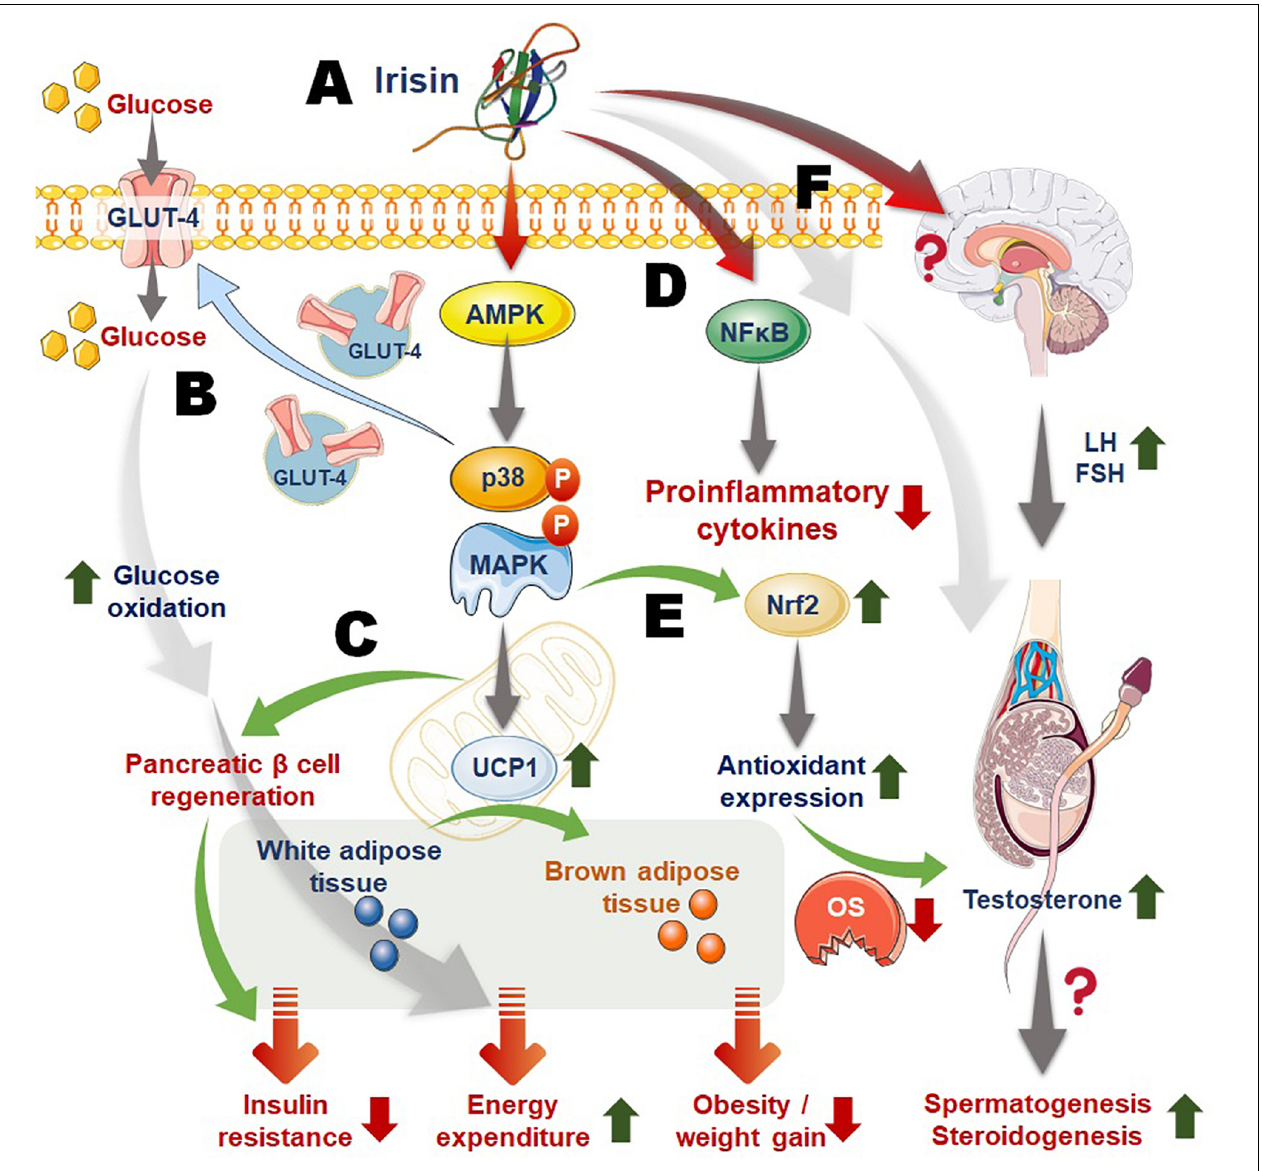
FIGURE 2 | Mechanism of irisin actions linking energy homeostasis, obesity, inflammation, and male reproduction. (A) Irisin acts via activation of the AMP activated protein kinase (AMPK), P38, MAPK (mitogen activated protein kinase) pathway; (B) irisin-activated pathway upregulates glucose transporter 4 (GLUT4) expression and transportation to membrane, aiding cellular glucose uptake that follows increased glucose metabolism and energy expenditure; (C) irisin also induces the expression of mitochondrial uncoupling protein 1 (UCP1) that aids conversion of white adipose tissue to brown adipose tissue, resulting in raised total body energy expenditure, as well as facilitates pancreatic β -cell regeneration that contribute to irisin-mediated reversing of insulin resistance; (D) irisin downregulates nuclear factor kappa-B (NF-kB) thereby playing role in suppressing inflammatory responses; (E) irisin-induced activation of Nrf2 (nuclear factor erythroid-2 related factor) may increase production of antioxidant enzymes thereby curbing excess reactive oxygen species (ROS) and oxidative stress (OS); (F) irisin may act on the HPG (hypothalamic-pituitary-gonadal) axis or directly upon the testicular cells to regulate male reproductive functions. Moreover, irisin actions to improve metabolic balance as well as to reverse obesity, inflammation and OS, may confer ameliorative impact upon obesity/inflammation/OS-mediated male